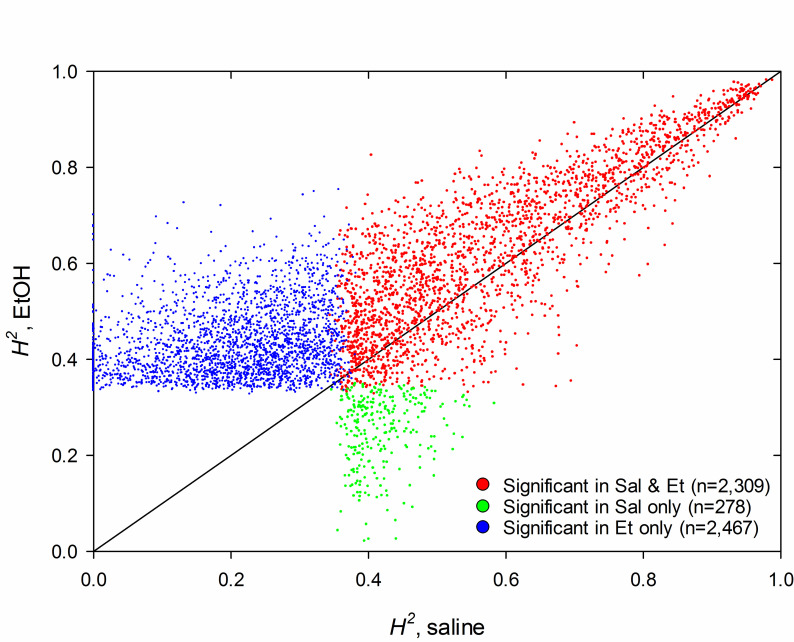
Heritability (H2) of expression for individual genes in the LXS RI panel.Only genes that were significantly heritable in the saline and/or ethanol (Et) pretreatment are shown (FDR<0.05; n=5,054). Each dot represents a single gene. Red dots: significant in both pretreatment groups; green dots: significant in saline only; blue dots: significant in ethanol only.